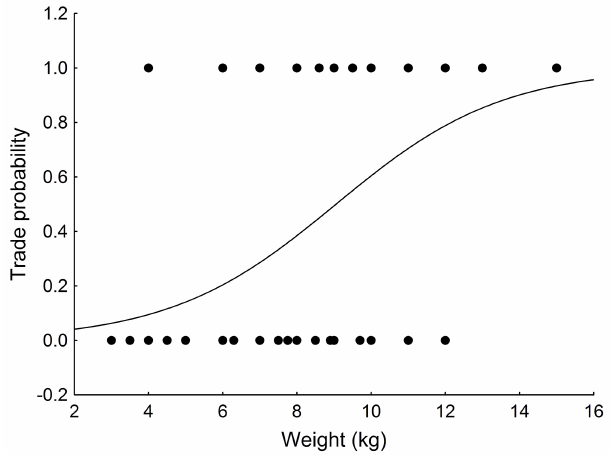
Fig. 5 . Trade probability of female tortoises to urban centers as a function of body weight.